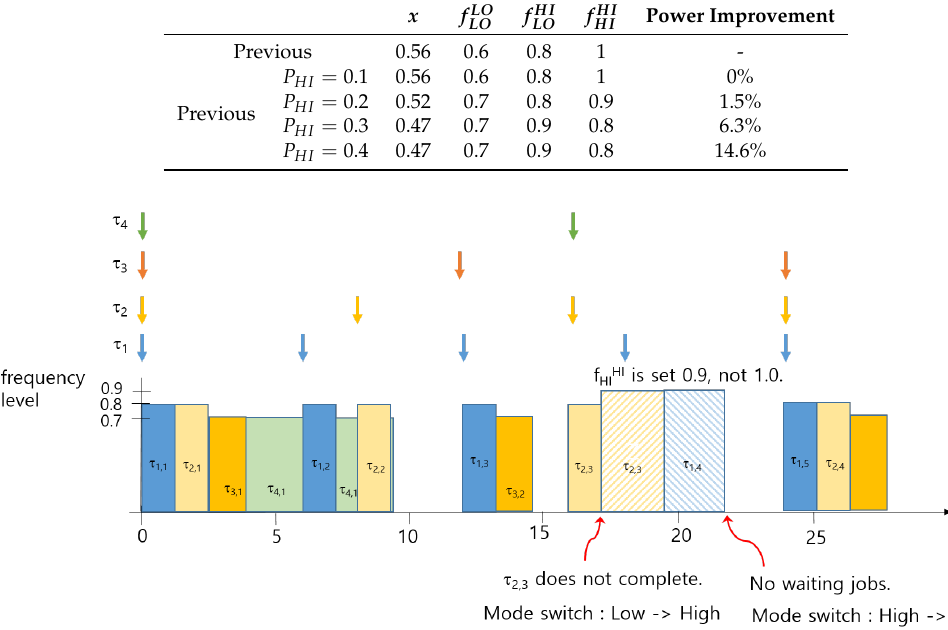
Figure 5. An example of proposed power-aware